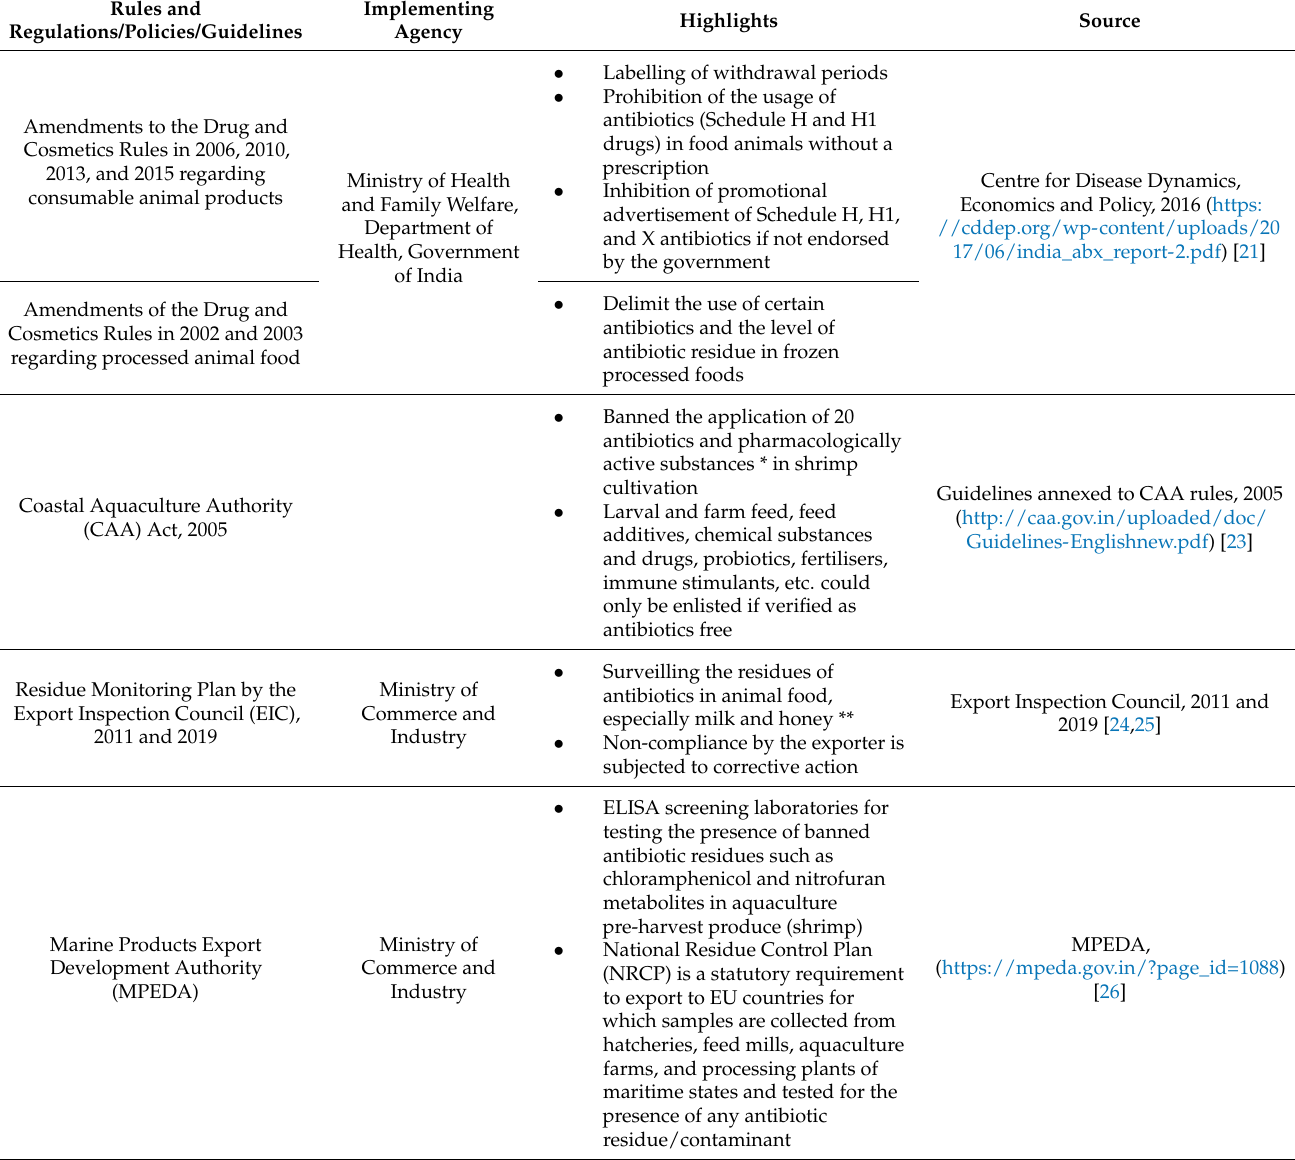
Table 2. Rules, regulations, policies, and guidelines to contain AMR in aquaculture and livestock products in